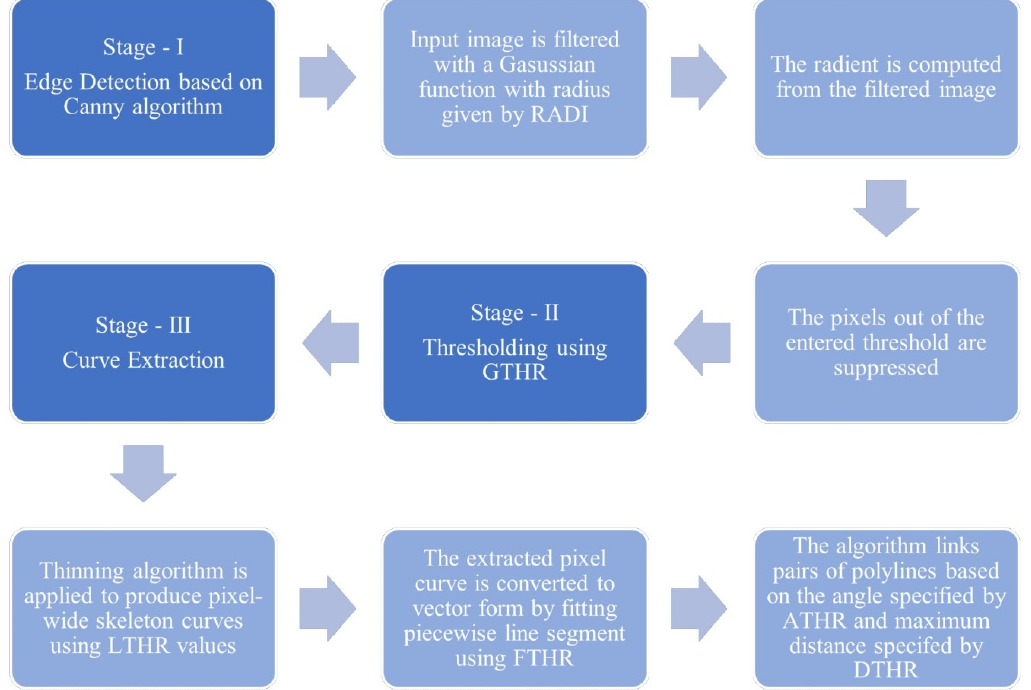
Figure 10. The flowchart of main and substages of LINE module.3. Discussion and Concluding Remarks.